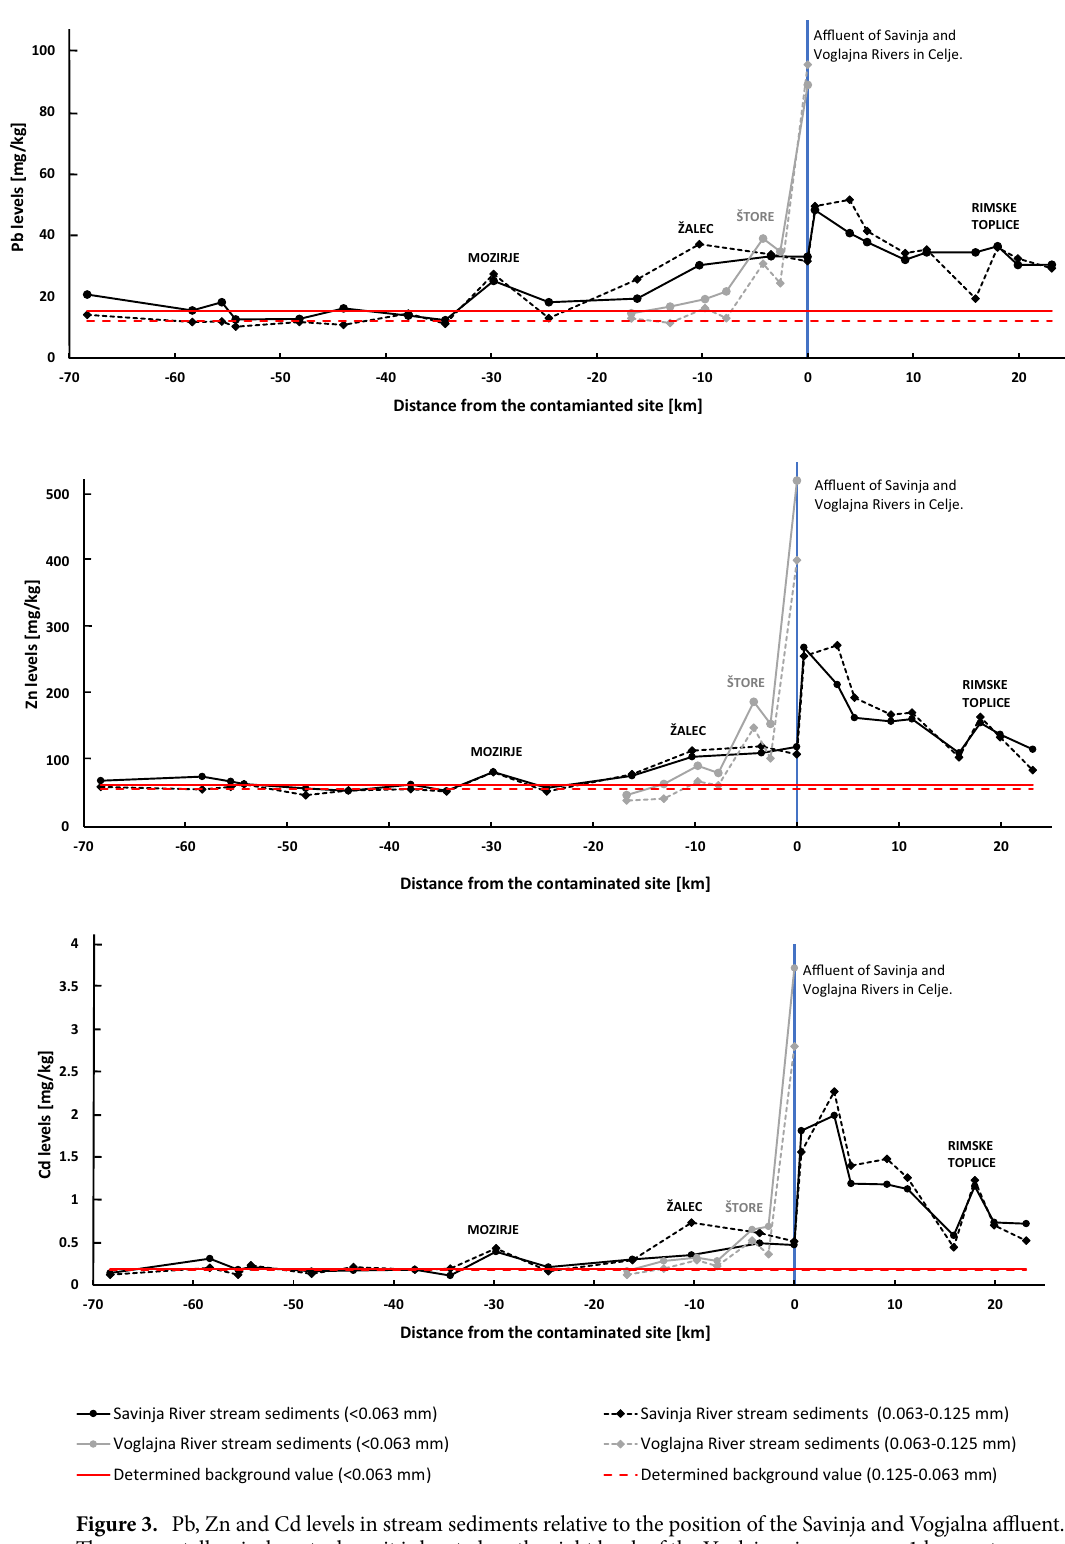
Figure 3. Pb, Zn and Cd levels in stream sediments relative to the position of the Savinja and Vogjalna affluent. The pyrometallurgical waste deposit is located on the right bank of the Voglajna river, approx. 1 km upstream Savinja and Voglajna rivers. X-axis presents distance according to the water flow